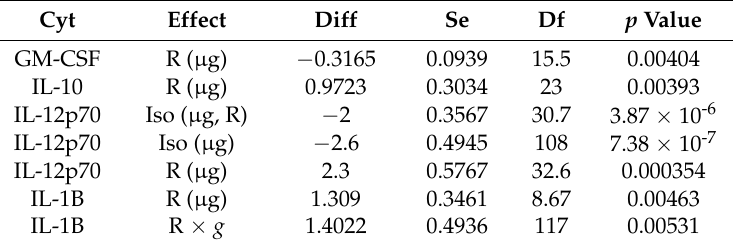
Figure 4. Cytokine concentration in cell culture medium. Cells were irradiated 2 Gy and subsequently incubated in 1g or µ g. After 24 h cytokine concentration was measured. Radiation induced cytokine production in µ g but not in 1 g . Isoproterenol treatment prior to radiation prevented the production of all cytokines. Bars represent mean + 1 SEM from 10 independent experiments. The synergistic effect of isoproterenol and radiation in µ g (Iso × R( µ g)) was significant for all four cytokines. Statistical analyses are summarized in Tables 4 and 5. Table 4. Significant differences in mean transformed cytokine concentration (0.8 Gy). Effects listed below are described in Table 7.